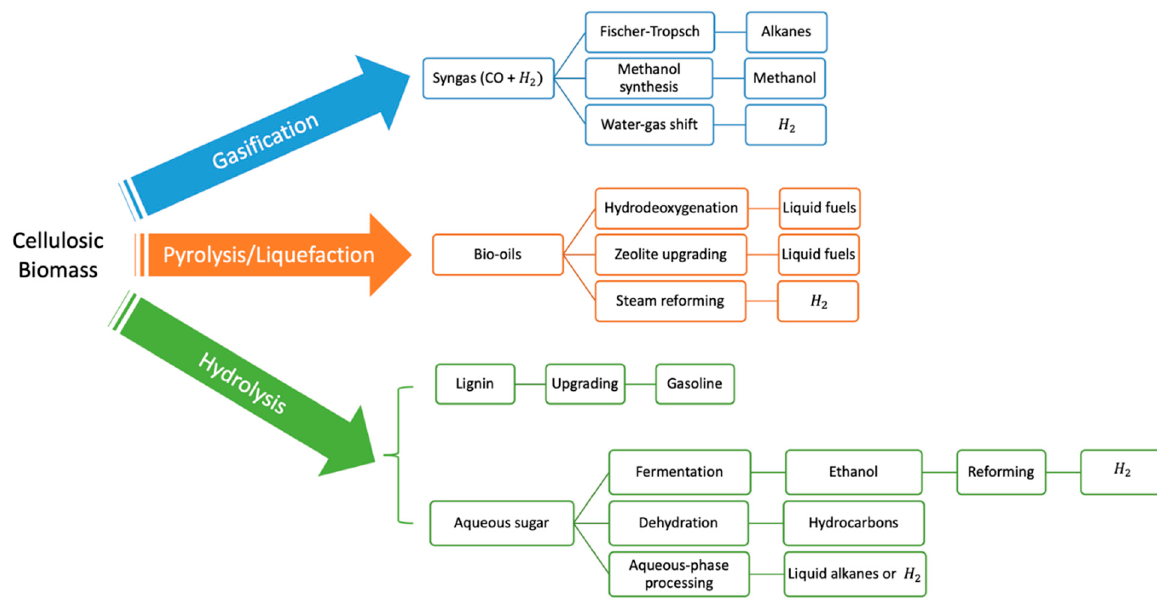
Figure 1. Process for the fuel production starting from cellulosic biomass. Pyrolysis oil is an attractive renewable fuel used as an alternative to petroleum (fossil) fuel to minimize the environmental impact of the latter. However, the pyrolysis oil contains a high amount of oxygen, between 20% to 40%, which leads to low energy density, high acidity, and thermal and low chemical stability [15–18]. Therefore, the oxygen should be extracted from the oil; the reaction of hydrodeoxygenation (HDO), specifically the direct deoxygenation method, as described by the reactions below (for the case of fatty acids), can be used to remove the oxygen content in the presence of H 2 (Figure 2).